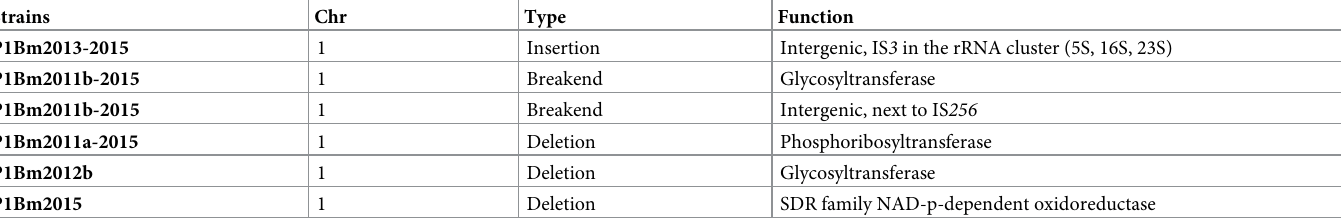
Table 5. List of large structural variations in the isolates of Patient 1. Using isolate P1Bm2009 as a reference, we mapped the long Nanopore reads of the subsequent isolates from Patient 1 to reveal large structural variations that escape SNP analysis. All structural variations are found in C1 and are fixed after their appearance in agree- ment with the SNP analysis (Fig 8). Isolates P1Bm2011a and P1Bm2012b, which originated from the same sputum sample as P1Bm2011b and P1Bm2012a, respectively, appear to come from separate lineages.